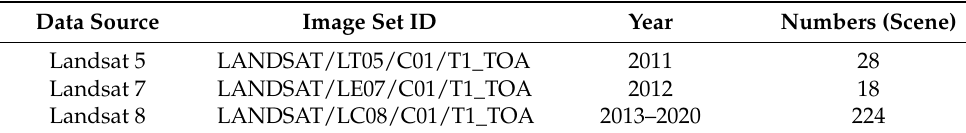
Table 1. Landsat image information .